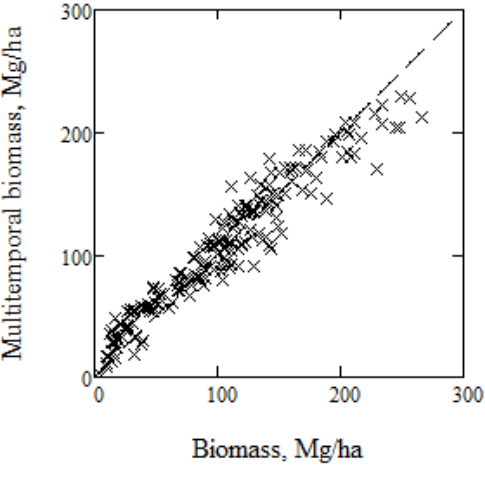
Figure 10. Scatterplot of biomass derived from a multi-temporal combination of 18 TanDEM- X InSAR pairs with respect to LiDAR-based biomass for 201 stands larger than 1